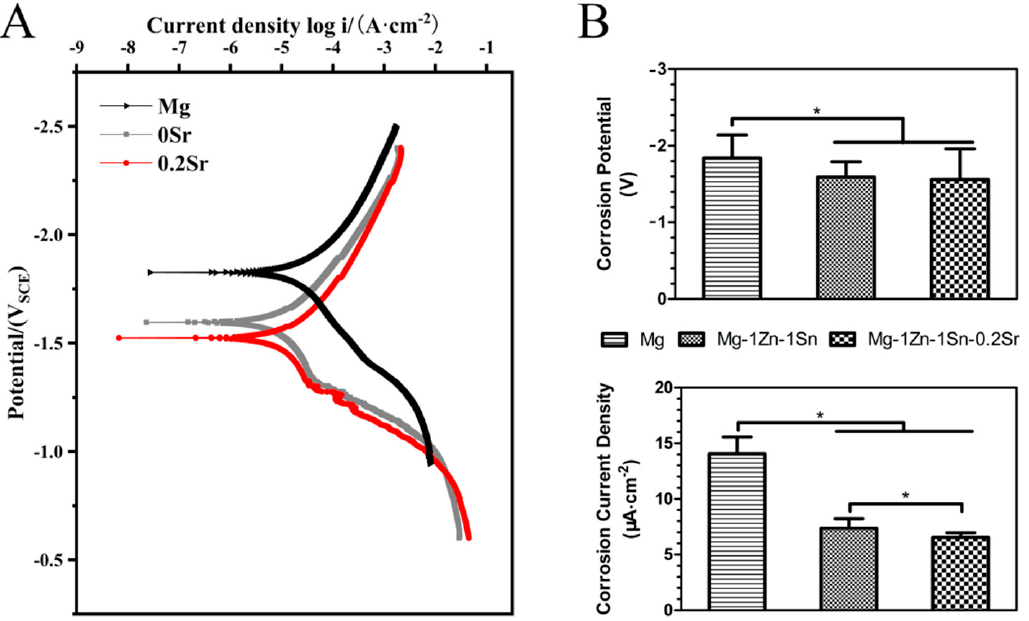
Figure 2. ( A ) Representative PDP curves of as-extruded Mg-1Zn-1Sn and Mg-1Zn-1Sn-0.2Sr alloys, ( B ) corrosion potential (E corr ) and corrosion current density (i corr ) obtained from Tafel extrapolation of PDP curves; values are mean ± SD, n = 3, * p < 0.05.